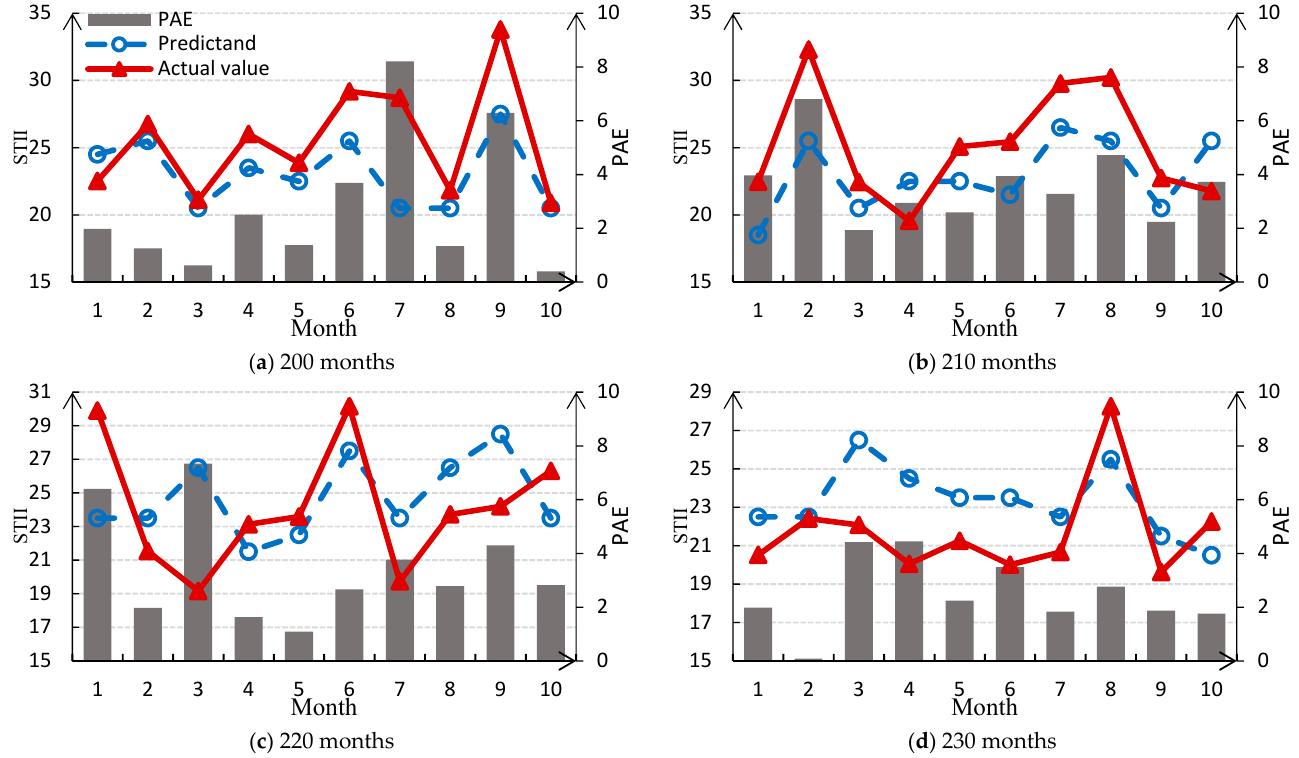
Figure 7. STII Prediction with WA-DBN model learned by different training data.